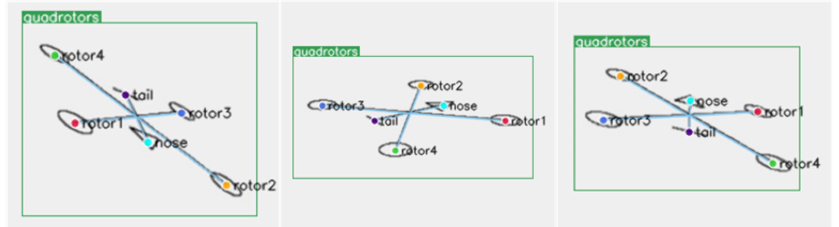
Figure 5. Some examples of quadrotor simulation data. It can be seen that the order of the motor shaft must be deduced from the nose and